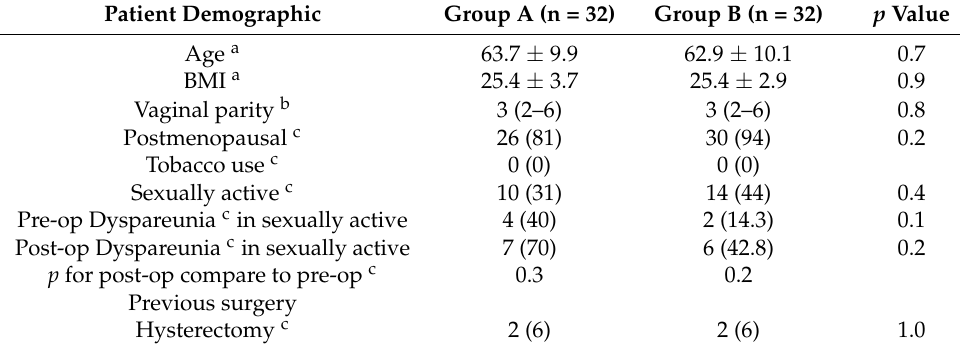
Table 1. Patient demographics.